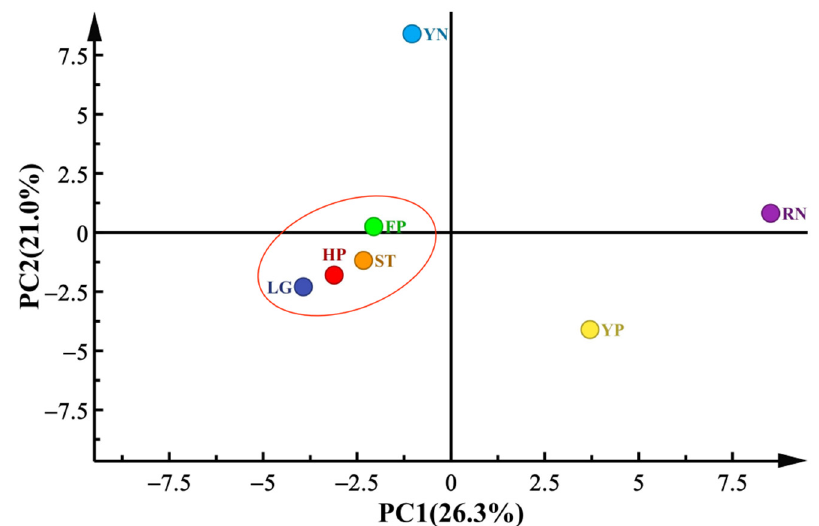
Figure 4. PCA analysis of aroma compounds. Differences in the flavor compounds in flat peach (FP), liguang peach (LG), honey peach (HP), yellow peach (YP), yellow nectarine (YN), red nectarine (RN) and shoutao (ST) from shihezi, Xinjiang.